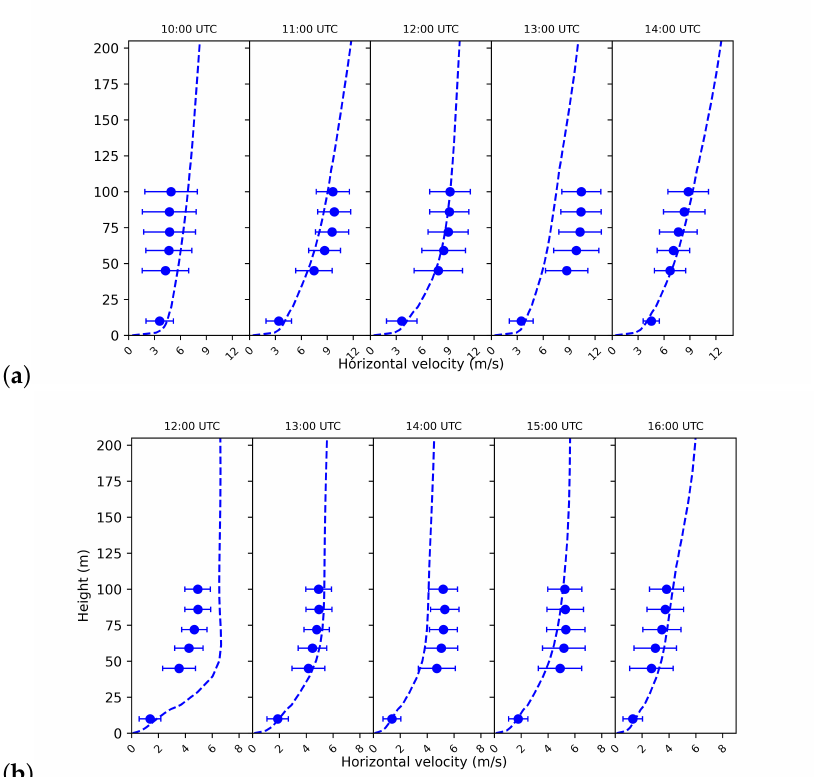
Figure 6. 10-min horizontal wind speed profiles for each hour at the tower on 21 ( a ) and 22 ( b ) September. Cup anemometer data are indicated with the blue circles and the simulation with the blue dashed